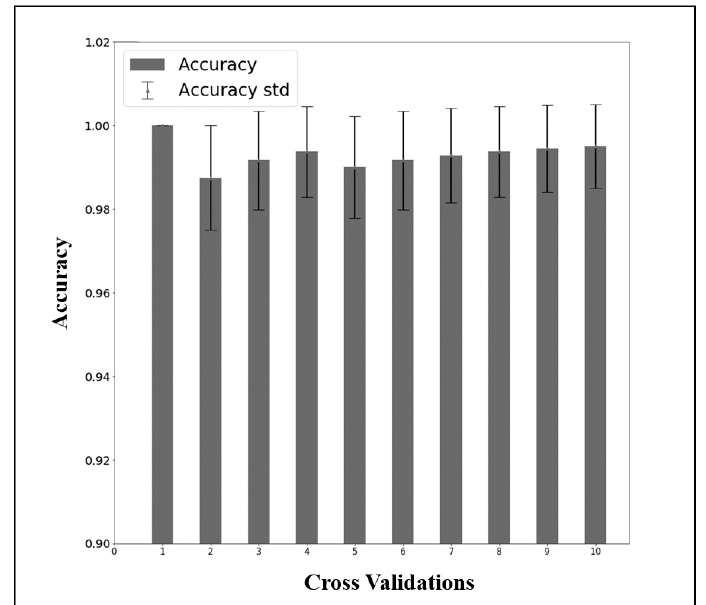
Figure 6. The results of 50 repetitions of 10-fold cross-validation of the data of the rest with closed eyes and mouth and nose breathing.